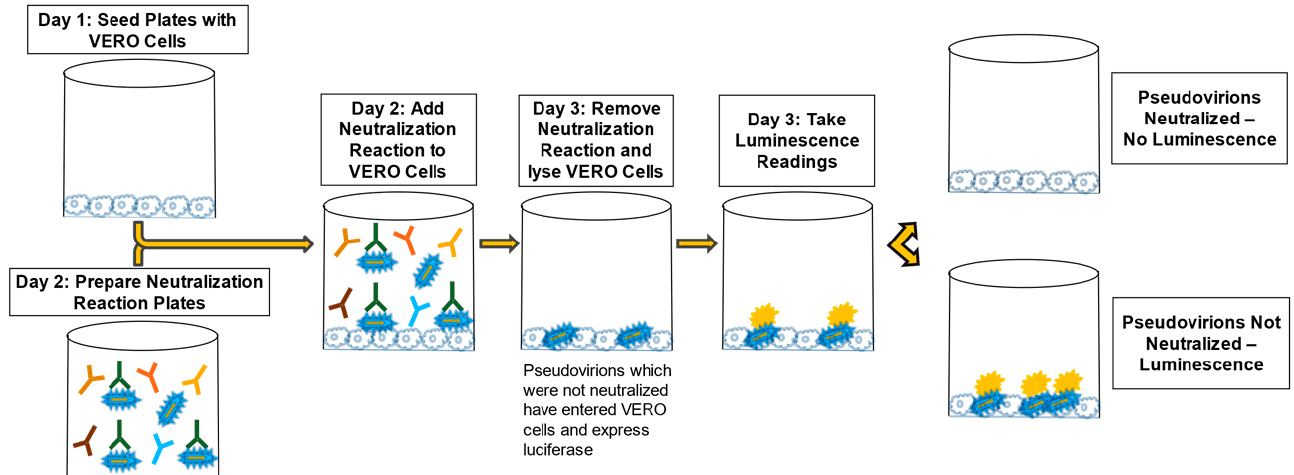
Figure 4. Graphic of PsVNA Method.